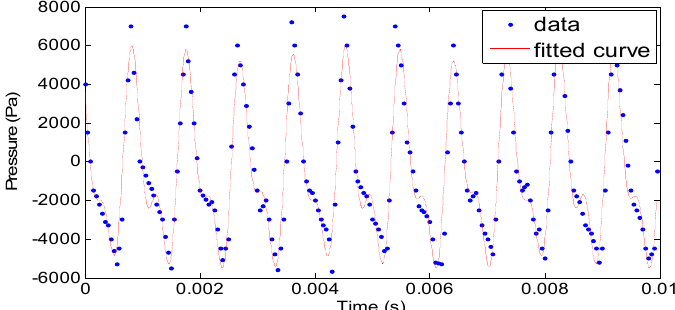
Figure 11. An example of time series data of pressure (p’) showing instability in a combustor [18] and the curve fit obtained using Fourier transforms [28].